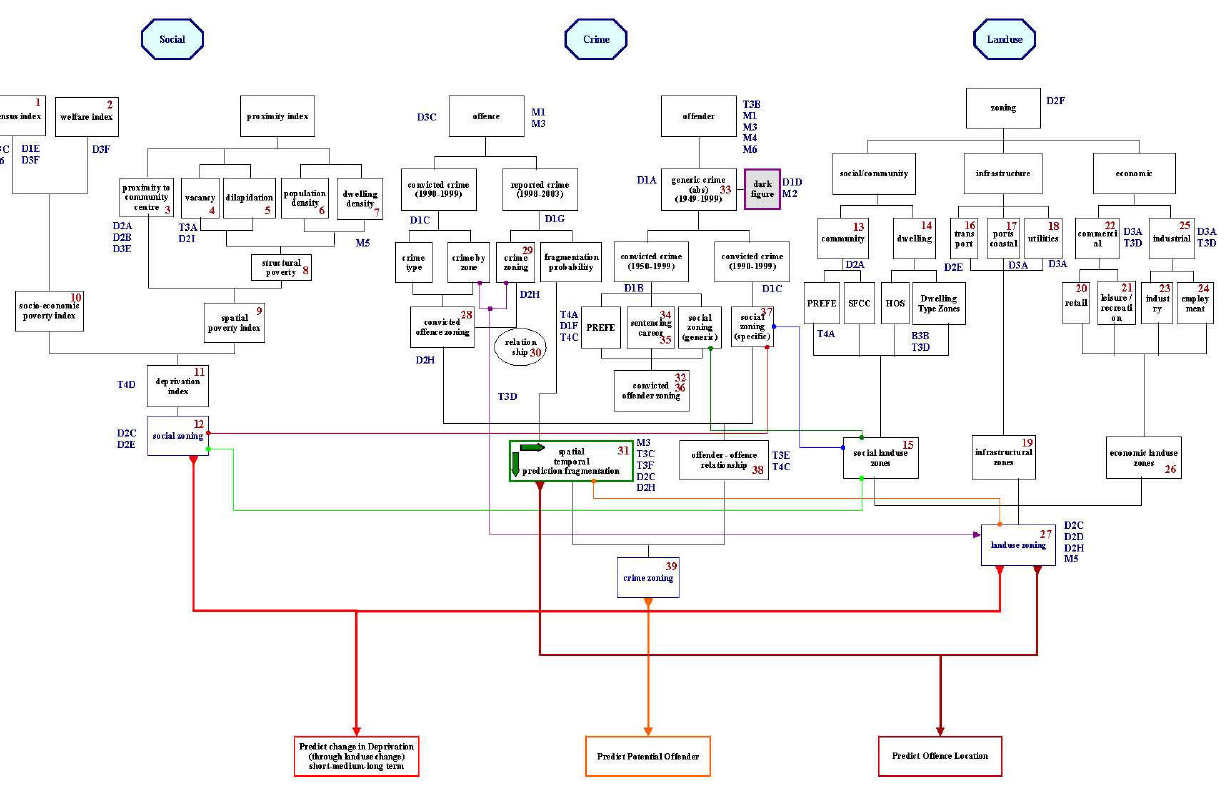
Figure 2. Mind-mapping the Crime-Social-Landuse